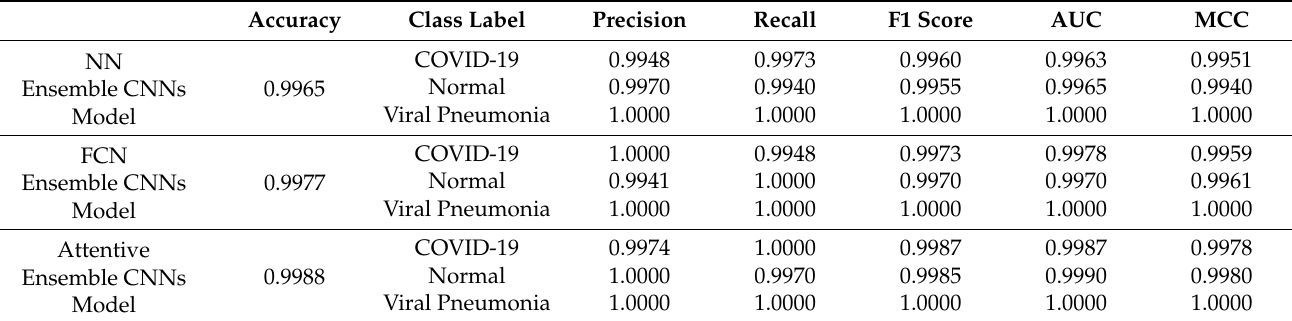
Table 5. Evaluation Metrics for Deep Ensemble Models using deep learning classifiers.